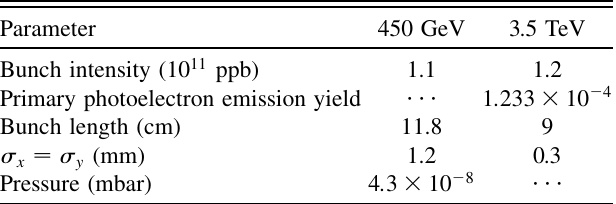
FIRST ELECTRON-CLOUD STUDIES AT THE LARGE . . TABLE III. Simulation parameters for sets A, B, and C (for B only an energy of 3.5 TeV with 50-ns bunch spacing is consid- ered, whereas for C only injection energy with 25-ns bunch spacing is simulated).